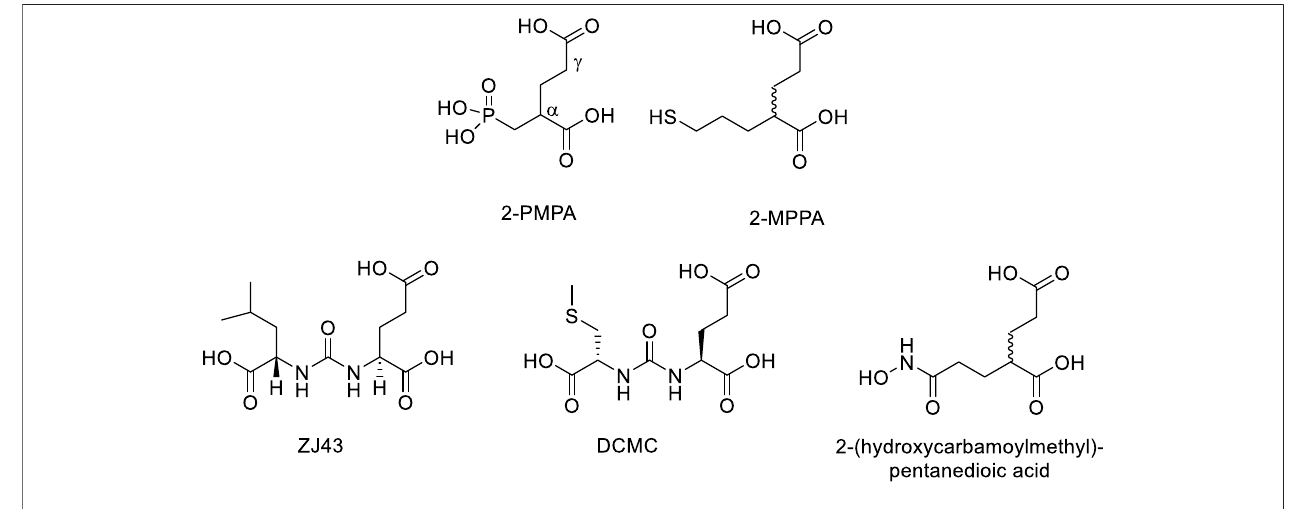
FIGURE 15 | Representative examples of GCPII